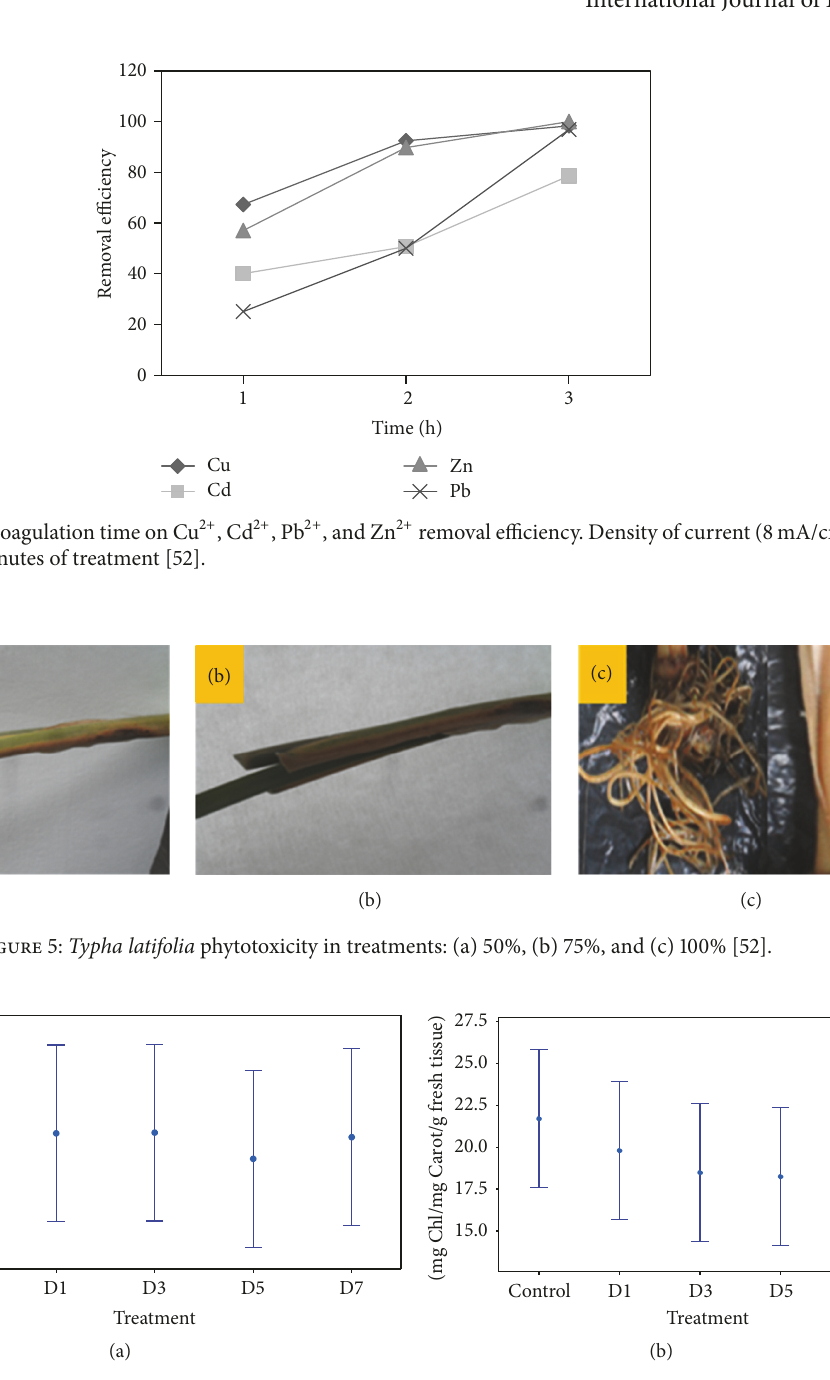
Figure 6: (a) Concentration of chlorophylls and carotenes in Typha latifolia . ∗ ANOVA 𝑝 < 0.05 and Dunnett’s multiple range test [52]. (b) Concentration of chlorophylls/carotenes in Typha latifolia . Both analyses were not significant at 𝑝 < 0.05